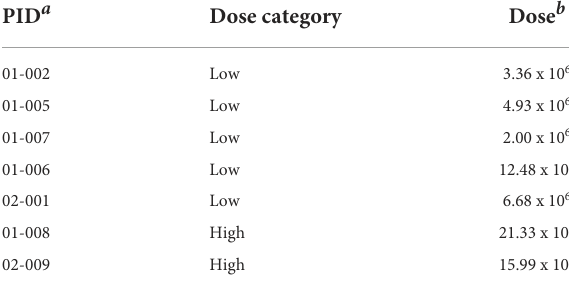
FIGURE1 Clinical trial overview and participant monitoring schedule.